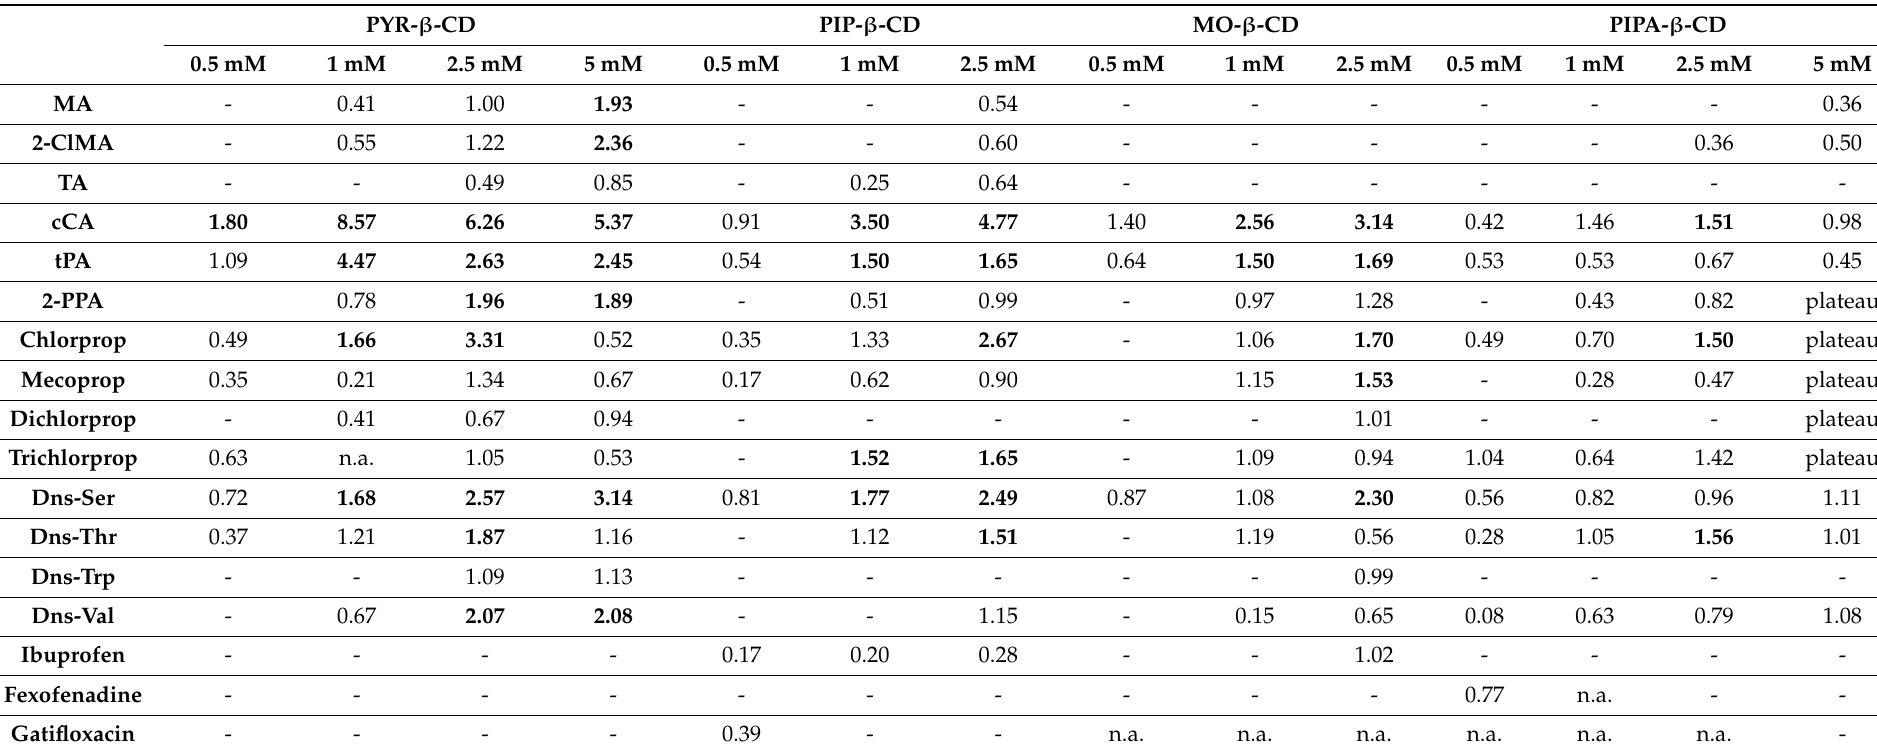
Table 2. Summary of chiral separations of the tested model racemates with the four ionizable N -heterocyclic CDs (the first set of CD derivatives) at pH 6.0, Indicating the maximum resolution values ( Rs